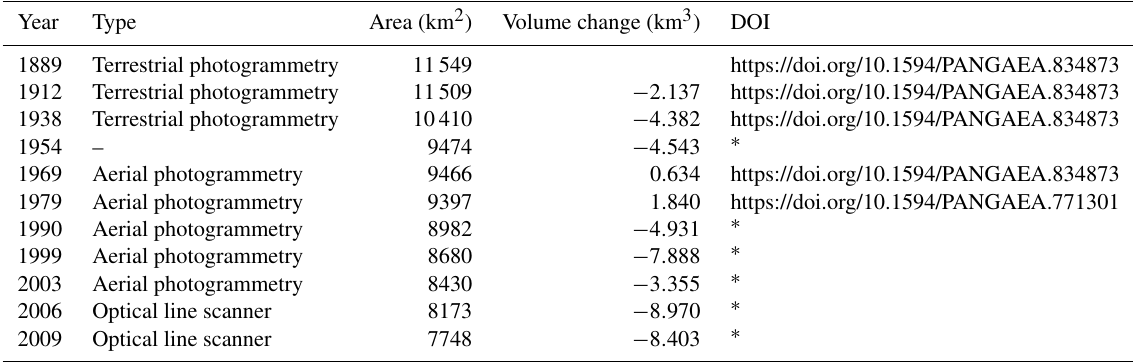
Figure 9. Graphical summary of the seasonal and annual mass balances of Vernagtferner from 1965 until 2014. The vertical bars represent seasonal values and the black line annual values. Table 1. Available maps of